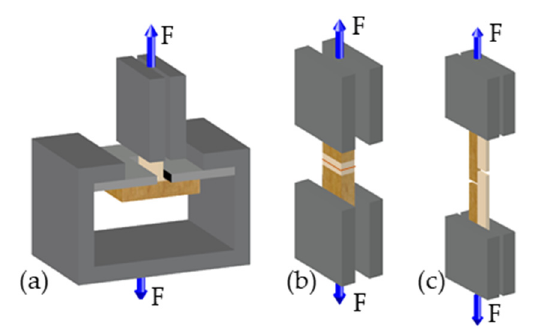
Figure 3. Schematic of the test setup for overmolded plywood specimens for strength measurements according to DIN 52 188 [37] and DIN EN 302-1 [34]: ( a ) test setup for tensile strength perpendicular to the plane of the board σ P , ( b ) test setup for tensile strength perpendicular to the edge σ E , and ( c ) test setup for tensile shear strength σ S .